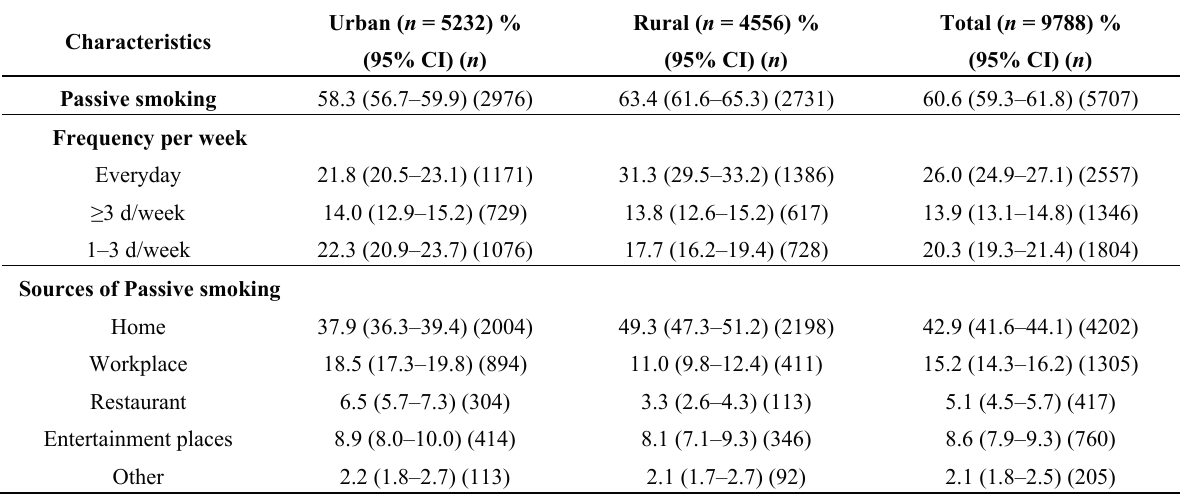
Table 2. Percent distribution and corresponding 95% confidence intervals (CI) of passive smoking among non-smoking women aged 18 years or over in Jilin Province,